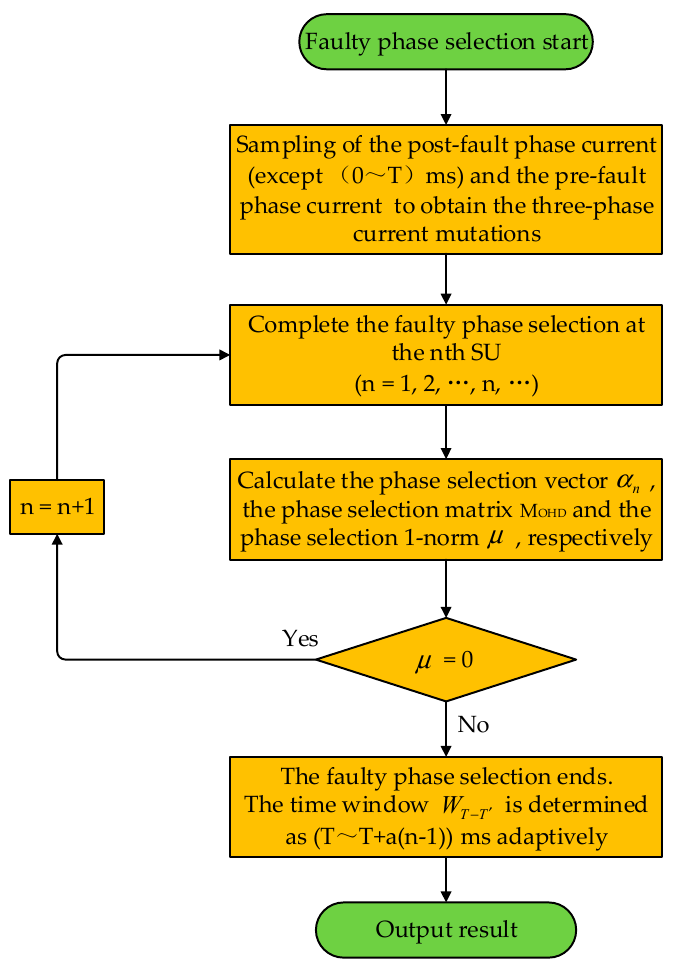
Figure 7. Flowchart of faulty phase selection method based on M OHD. The time window W T-T’ is determined as from T to T+a(n-1) after the fault. With the M OHD and W T-T’ , the proposed faulty phase selection method can be adapted to different scales of the distribution system. The effect of the missing sampling data on the faulty phase selection results is also taken into account in this method. In addition, the W T-T’ can provide a reliable transient database for the rest of the transient-based relay protection methods. 5. Simulation Verification and Results Analysis In this paper, a typical medium voltage distribution system is modeled in a Power Systems Computer-Aided Design/Electromagnetic Transients, including the DC. The three-phase current mutation is collected in PSCAD/EMTDC, and the similarity coeffi- cient is calculated in MATLAB. The distribution system model is shown in Figure 8.